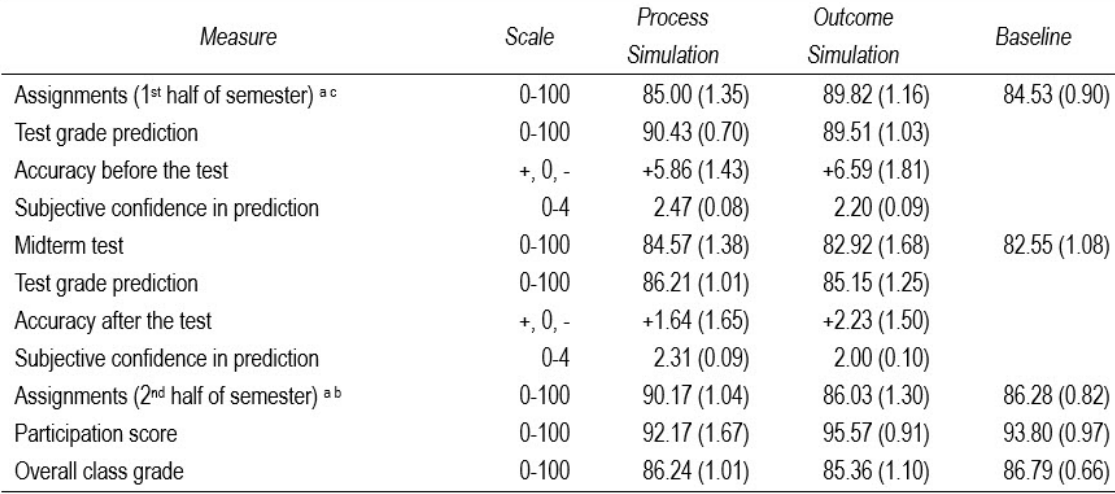
Mean and Standard Error of the Mean (in Parentheses) of Main Dependent Variables